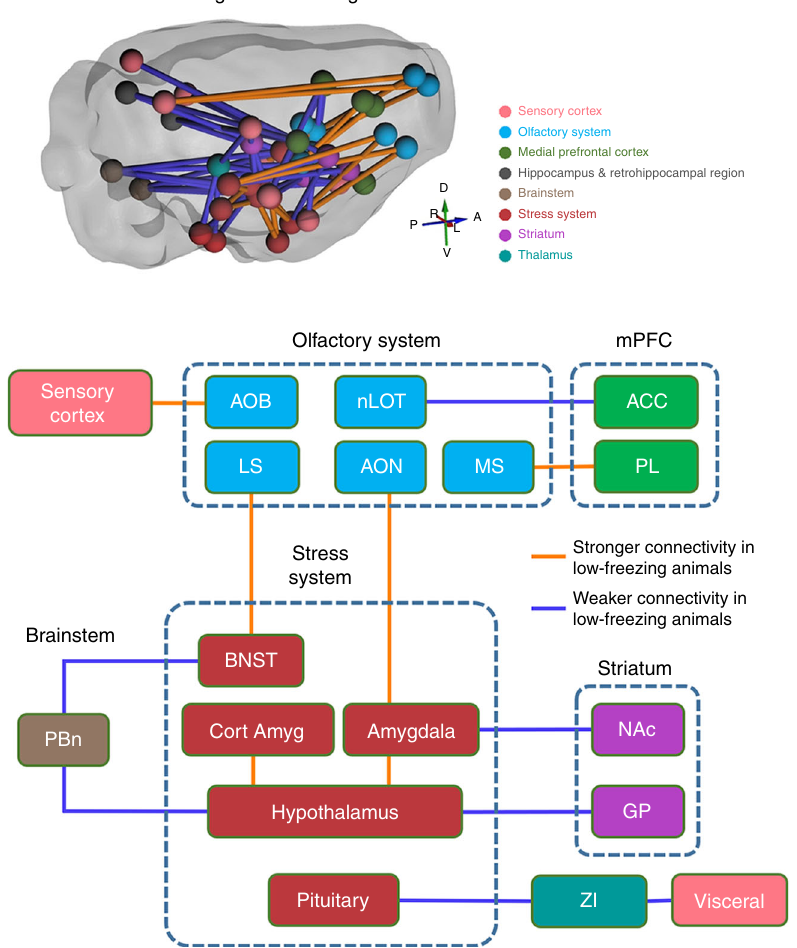
Fig. 6 Diagram of freezing-associated neural network. The diagram includes neural circuits showing signi fi cant correlation between pre-trauma RSFC and total freezing time shown in Fig. 5. Brain regions are grouped and color coded based on the brain systems they belong to. Orange lines indicate stronger connectivity in low-freezing animals. Blue lines indicate weaker connectivity in low-freezing animals. See the caption of Fig. 5 for the